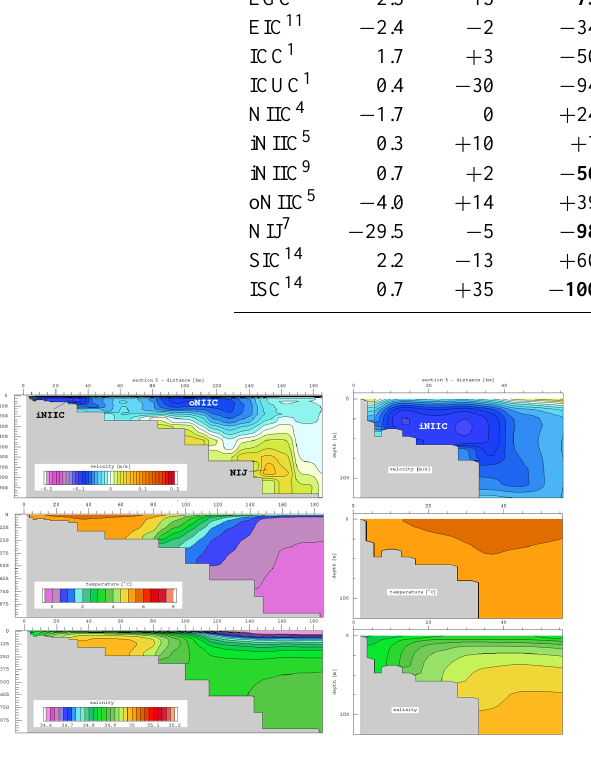
Fig. 10. Simulated 1992–2006 mean of flow (positive (red) values denote westward flow), temperature and salinity across section 5. See Fig. 6 for section